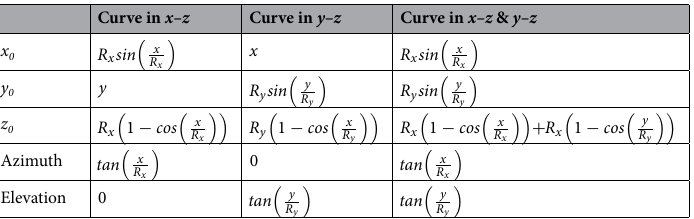
Table 1. Adjusted phasing coordinates transformed according to the corresponding radii of curvature in the x–z and/or y–z